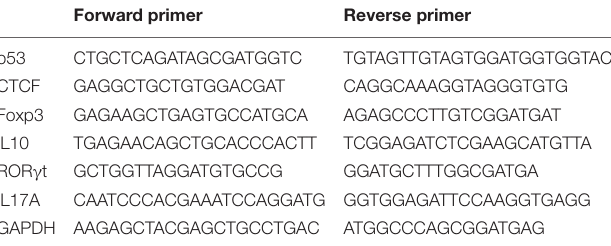
TABLE 2 | Primer sequences for real-time qPCR. Forward